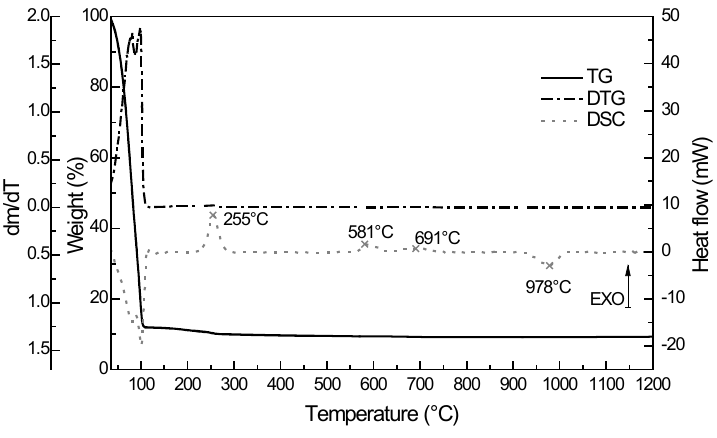
Figure 2. The record from thermogravimetric analysis for